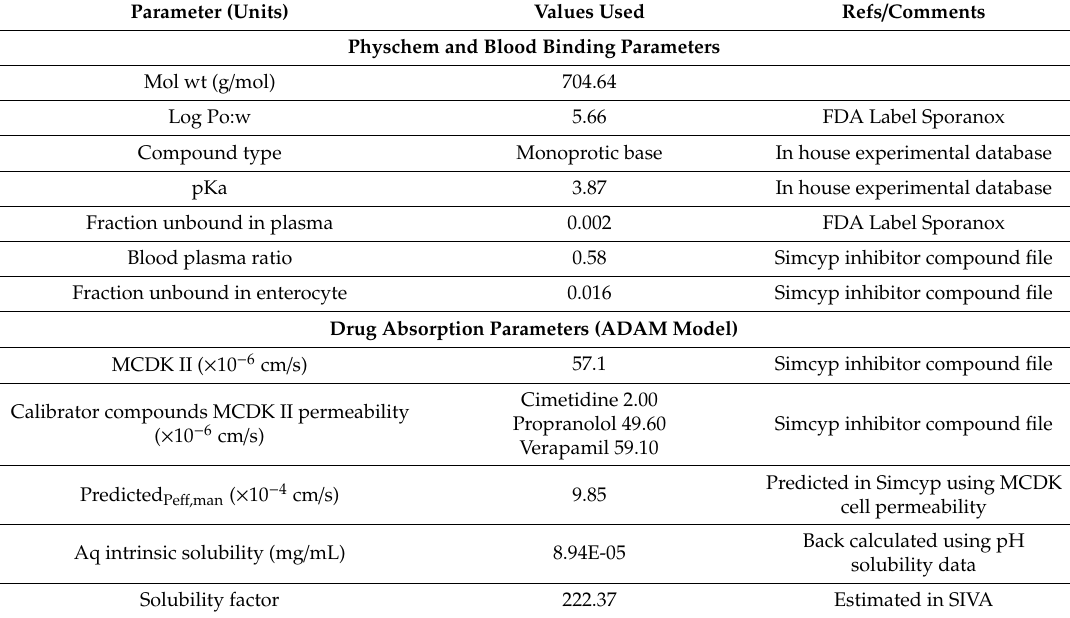
Table 3. Values of physicochemical and pharmacokinetic parameters used in PBPK models for itraconazole in the present